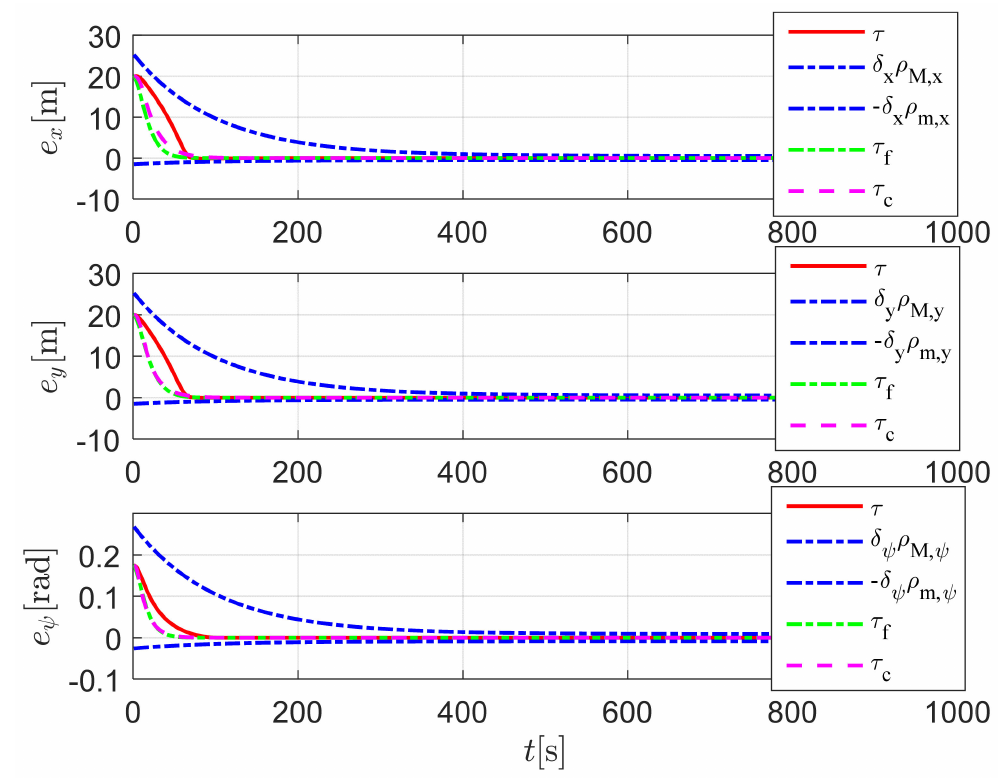
Figure 4. The time response curves of positioning error in Case